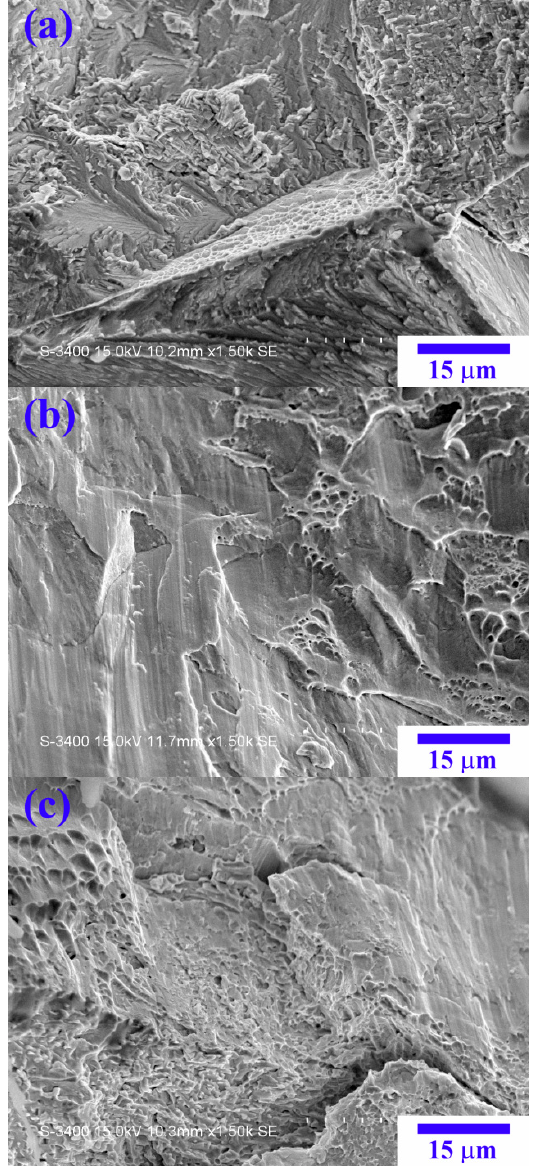
Figure 13. SEM images of fracture surfaces of the ( a ) X 0 ; ( b ) X 0.5 ; and ( c ) X 1 alloys after compressive test.